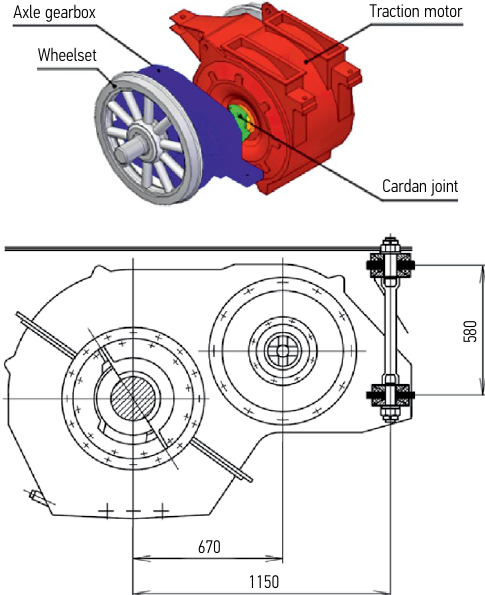
Fig. 2. The wheelset driven by a cardan shaft in a hollow rotor (top) and the suspension of the axle gearbox on the bogie frame (bottom)